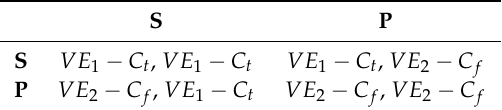
Table 4. Payoff matrix A for Scalpel-Photorec ( S – P )